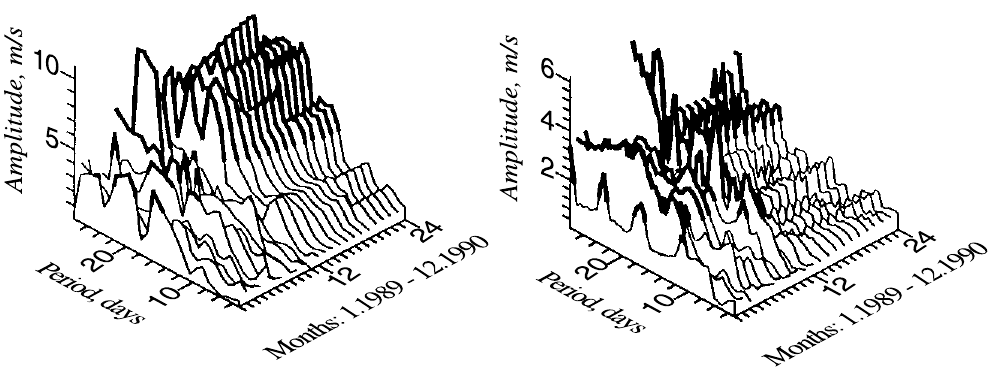
Fig. 10. Lower thermosphere zonal wind (semidiurnal tidal amplitude variations) dynamic spectra at East Siberia and Central